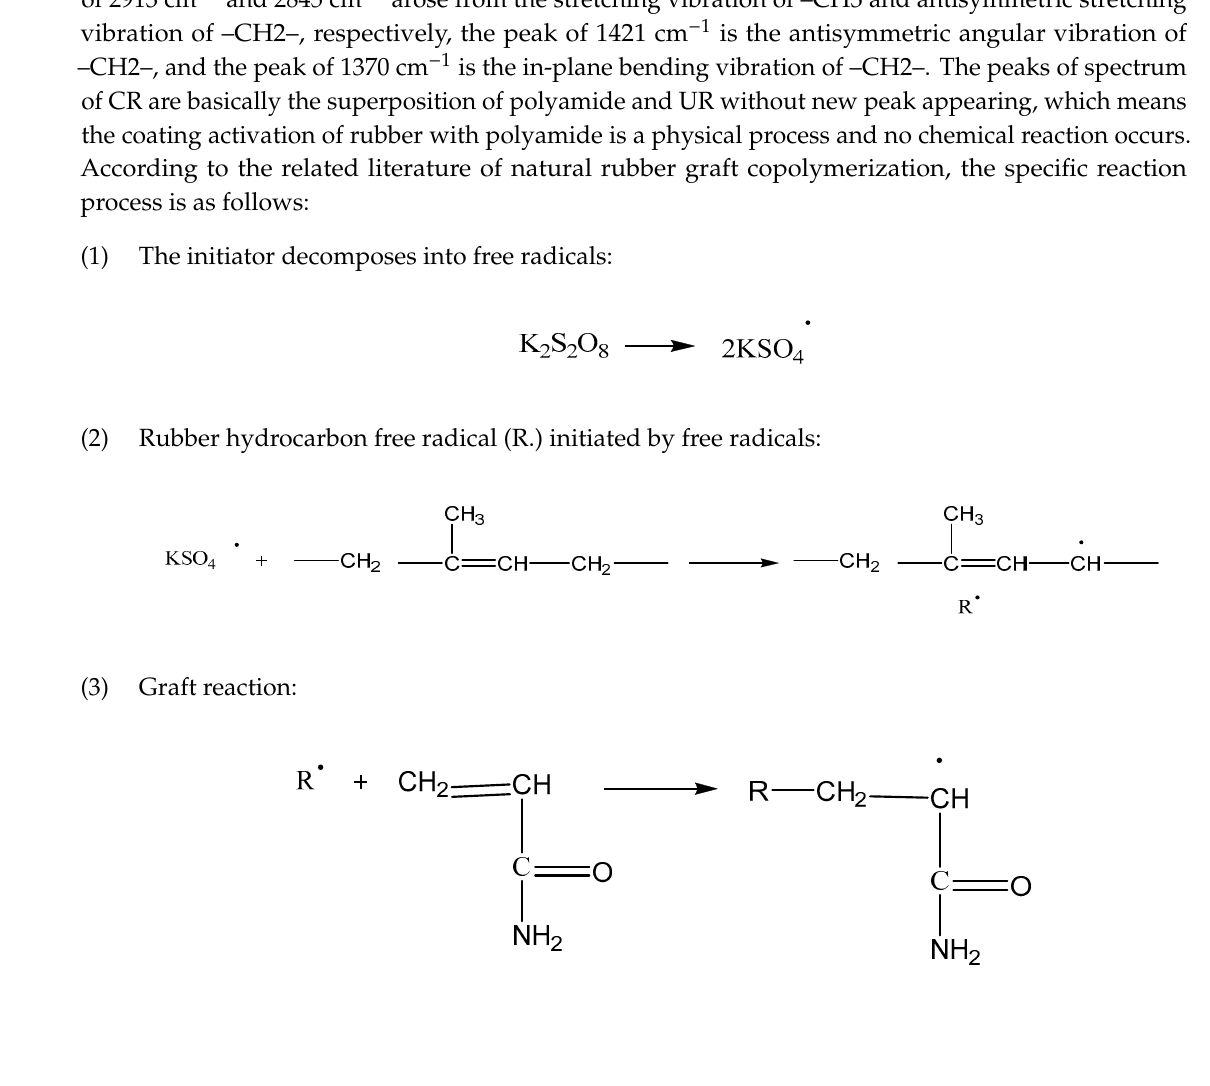
Figure 2. Fourier transform infrared (FTIR) spectra of crumb rubber. ( a ) spectra of polyamide 6, UR and CR; ( b ) spectra of acrylamide, UR and GR. The infrared absorption spectra of acrylamide, UR and GR are shown in Figure 2 b. In the curve of acrylamide, the peak due to the stretching vibration of –NH 2 is found at 3334 cm −1 [34] , and